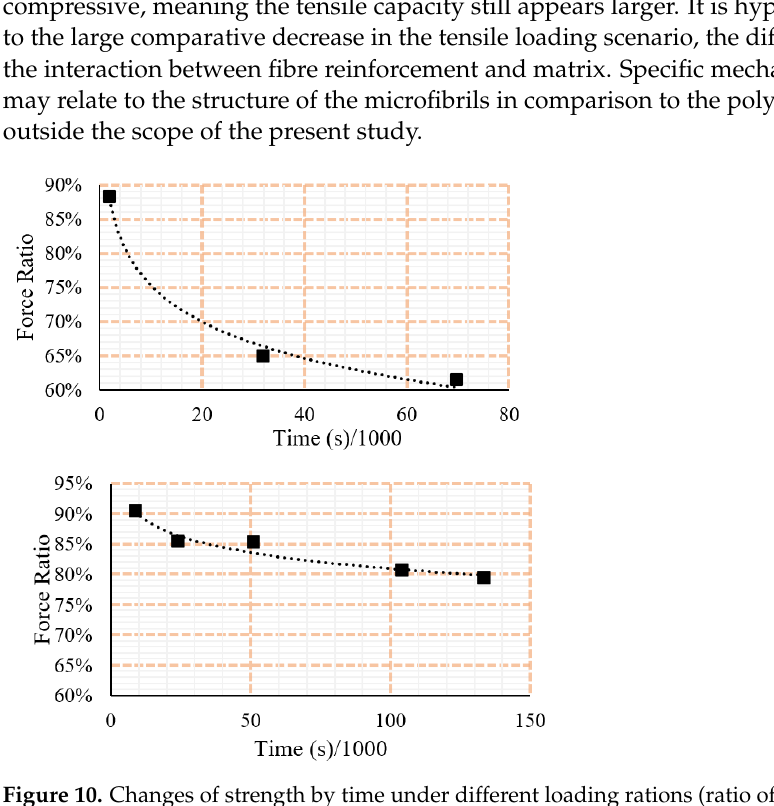
Figure 10. Changes of strength by time under different loading rations (ratio of sustained load to the ultimate load). ( Up ) failure curve under tensile loading and ( Down ) failure curve under compressive loading Please note that the scale is different in the two